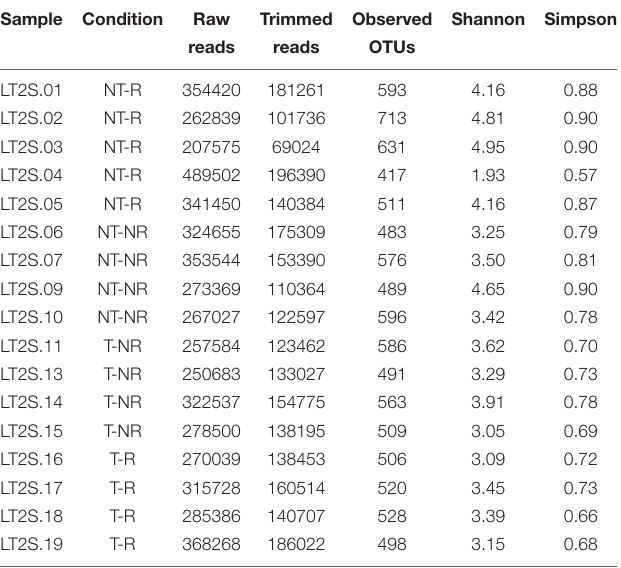
on the NMDS plot indicating high fungal community similarity,